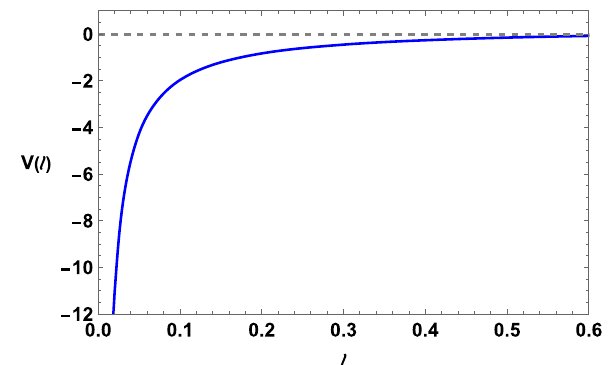
Table 1 Values of t ex , μ